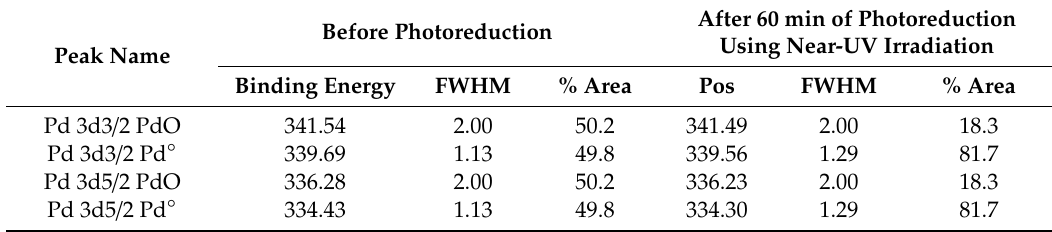
Table 5. High-Resolution X-ray Photoelectron Spectroscopy (XPS) Spectra Binding Energies and Peak Areas for the 0.25 wt% Pd–TiO 2